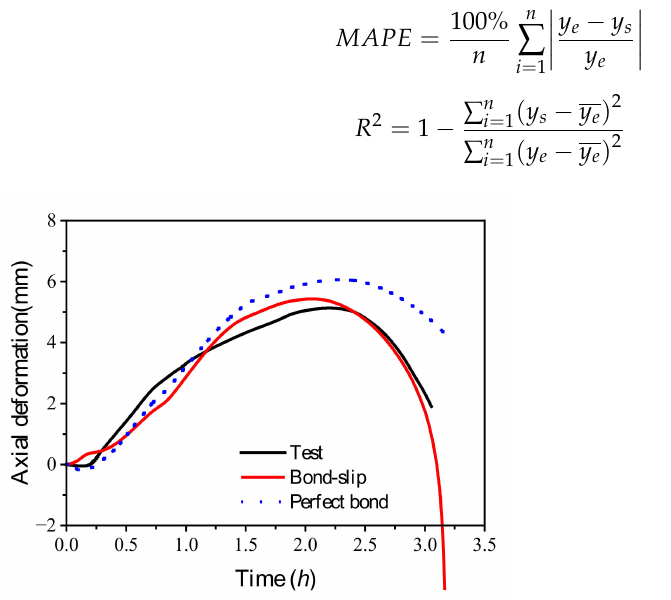
Figure 6. The comparison of the axial deformation-time curve of numerical simulation and test.